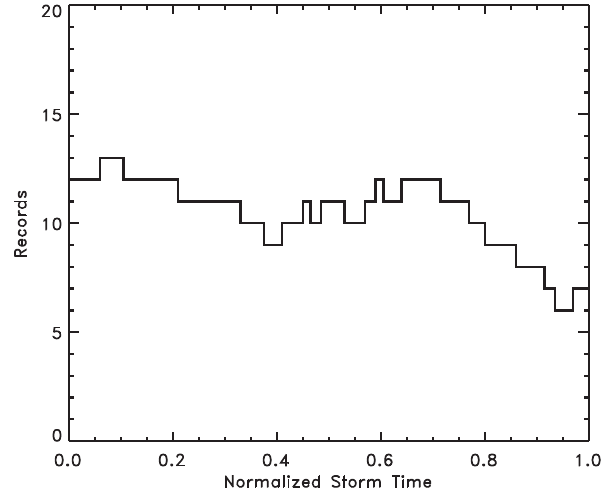
Figure 1 Fig. 1. Number of magnetic storms with auroral imaging as a